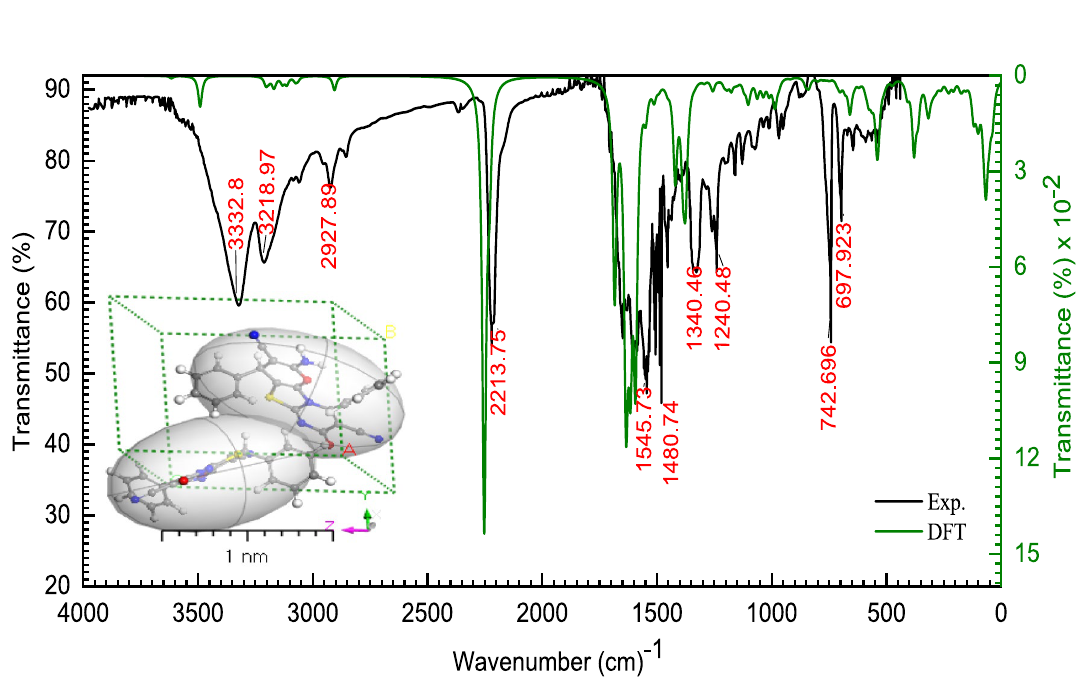
Figure 2. Experimental and theoretical FTIR; the inset is a 3D of an isolated molecule in the unit